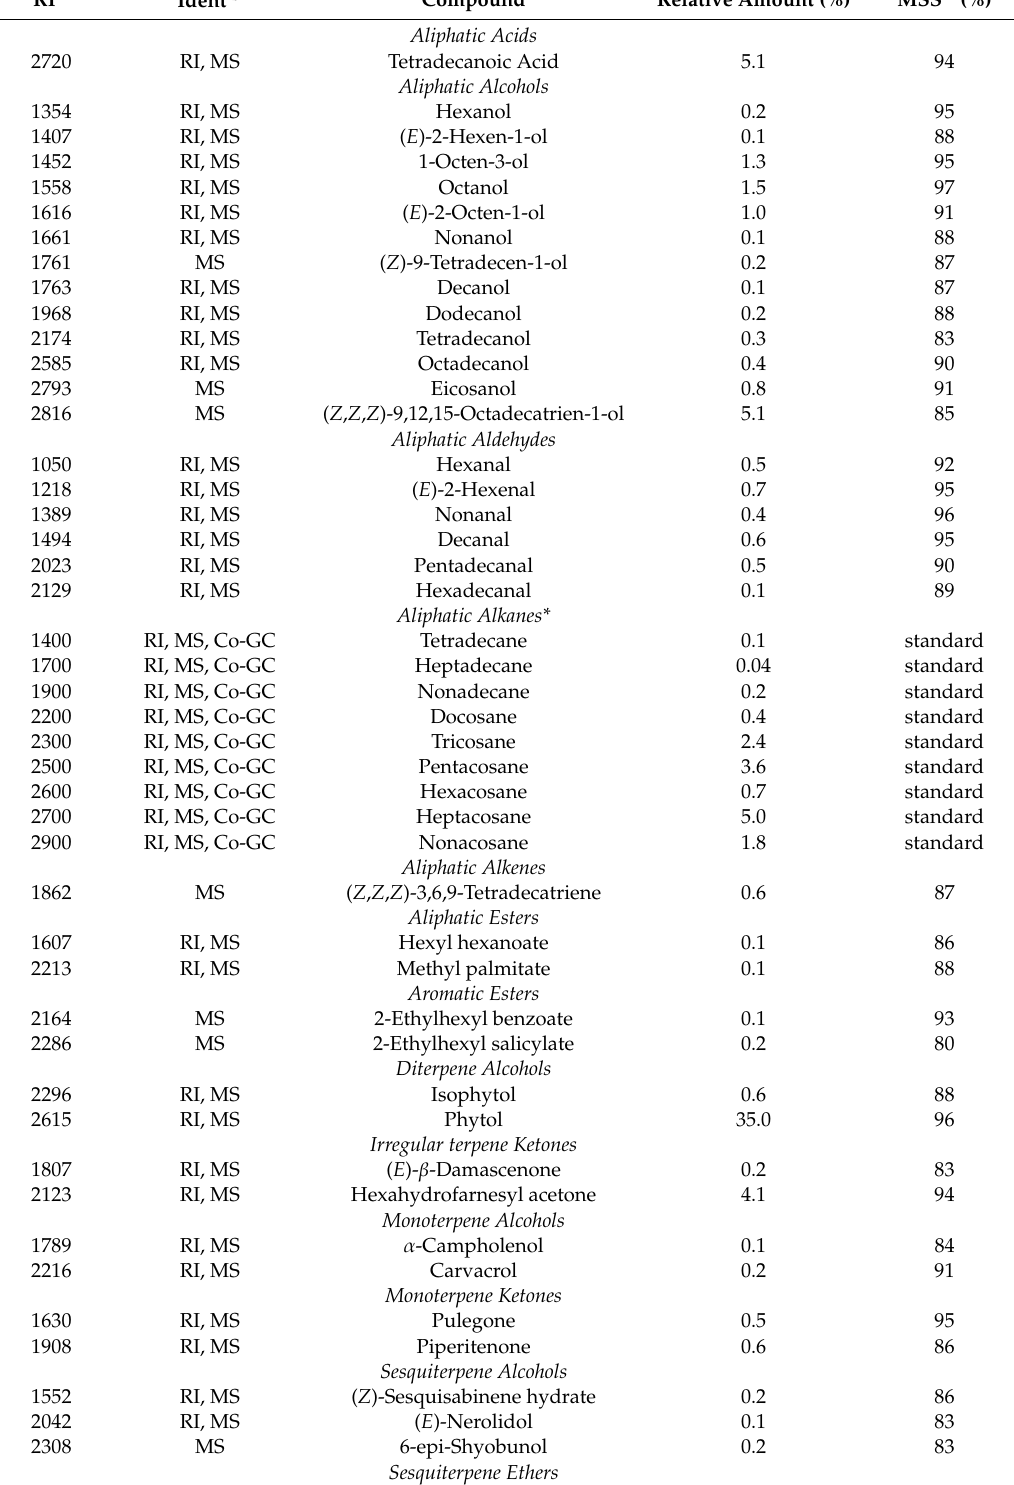
Table 1. Essential oil composition of Kalanchoe beharensis . Compounds belonging to the same chemical class and functional group [32] are arranged according to Kovats Retention Indices (KRI) of the Supelcowax 10